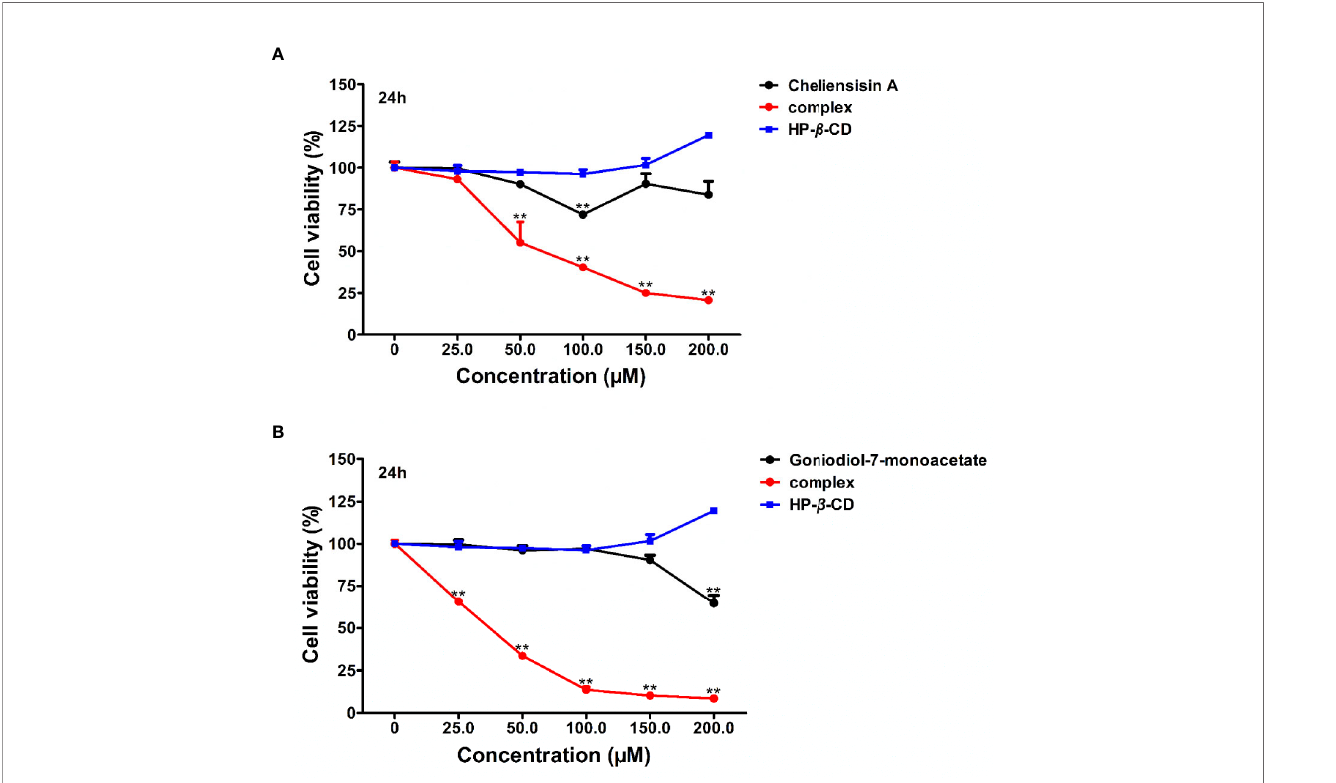
FIGURE 9 | Cytotoxic activity of hydroxypropyl- b -cyclodextrin (HP- b -CD) complexes of styryllactones was increased against human embryonic kidney 293T (HEK293T) cells. The cells (5×10 4 cells/ml) were cultured respectively in the absence or presence of various compounds and complexes (25.0, 50.0, 100.0, 150.0, 200.0 m M) for 24 h: (A) cheliensisin A, cheliensisin A/HP- b -CD complex and HP- b -CD; (B) gonidiol-7-monoacetate, goniodiol-7-monoacetate/HP- b -CD complex and HP- b -CD. Data are means ± SEM ( n =3). Results are representative of three separate experiments. **P <0.01 compared with the group (cell viability in 0 m